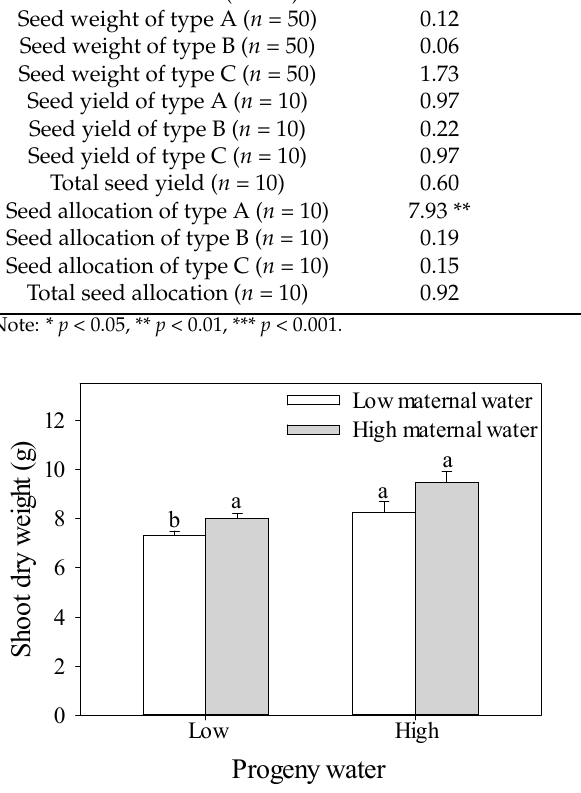
Figure 1. Effects of maternal and progeny water treatments on shoot dry weight per plant. Different lowercase letters represent significantly different means between plants with different maternal water treatments under the same progeny water treatment according to t -test ( p < 0.05). C content was not significantly affected by water treatment for maternal plants and progeny plants and their interaction (Table 1). C content ranged from 377.44 mg kg − 1